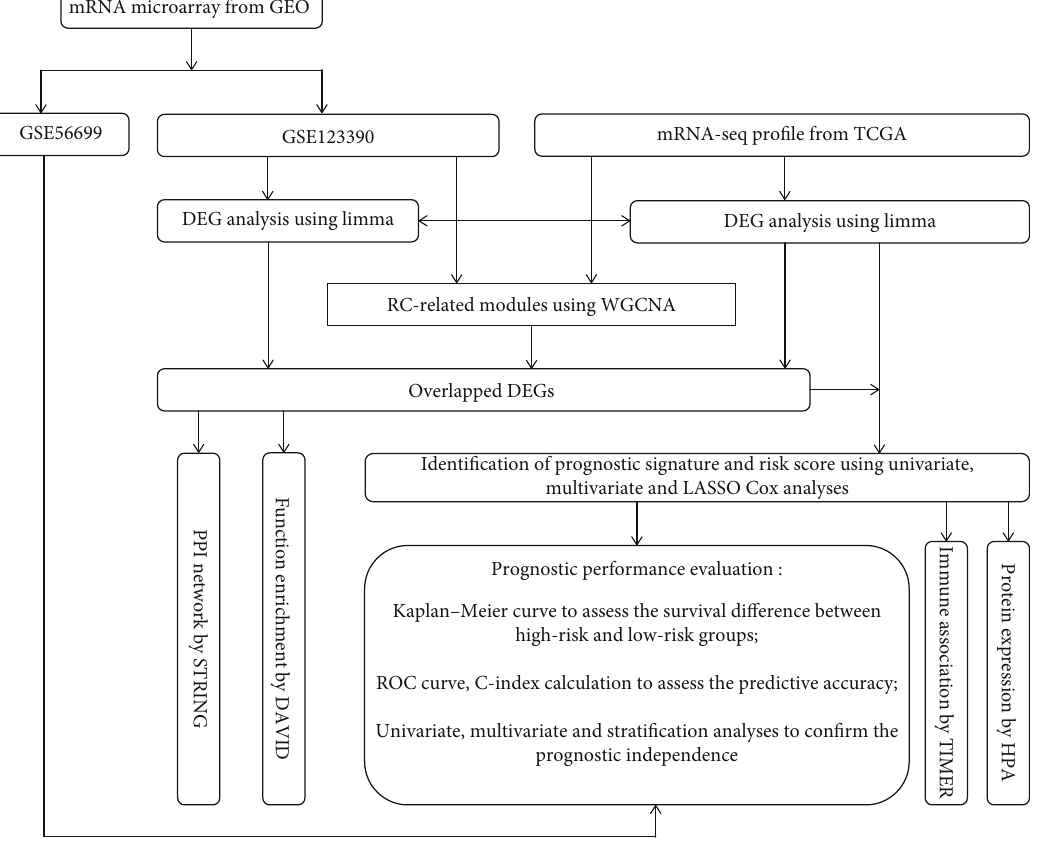
Figure 1: A study fl owchart for our